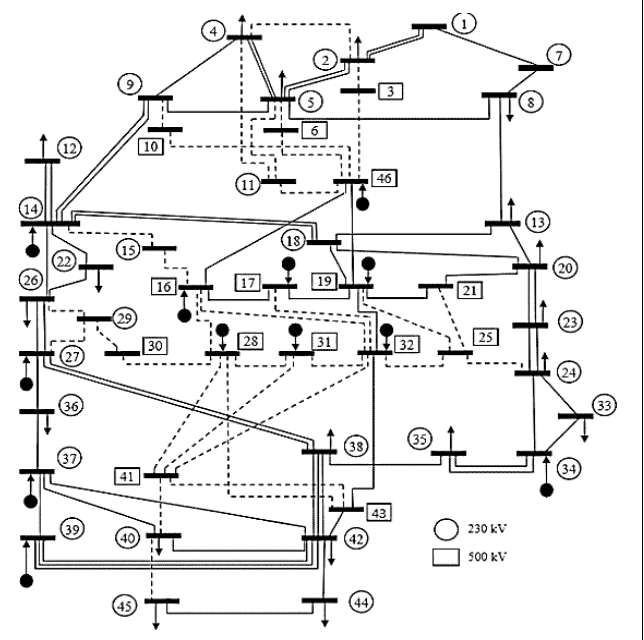
Figure 13: SB-46/79 test system topology.